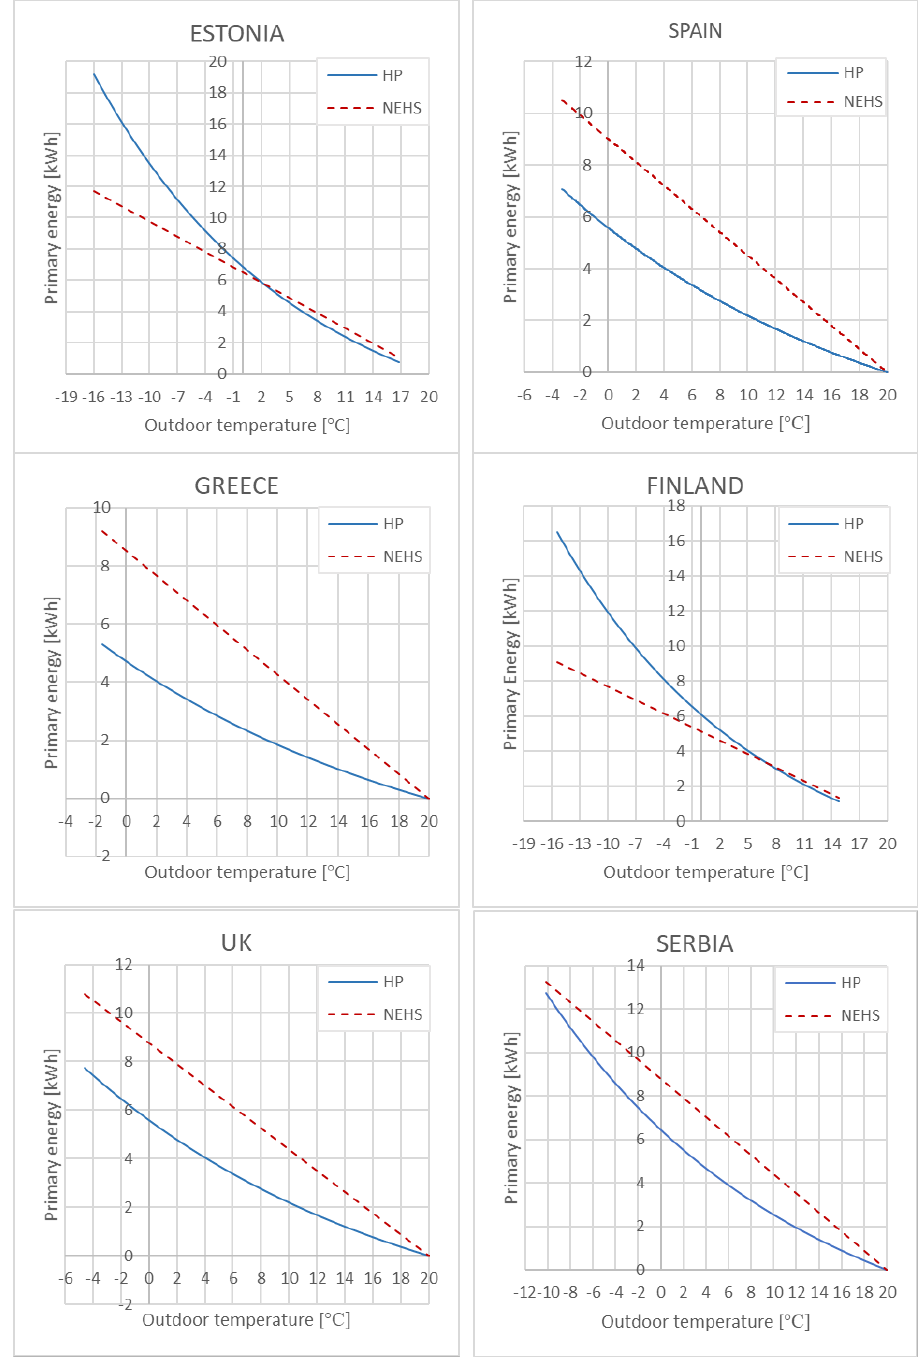
Figure 6. Primary energy intensity of NEHS and HP versus the maximum and minimum outdoor temperature observed per country [climatic data from Copernicus database].